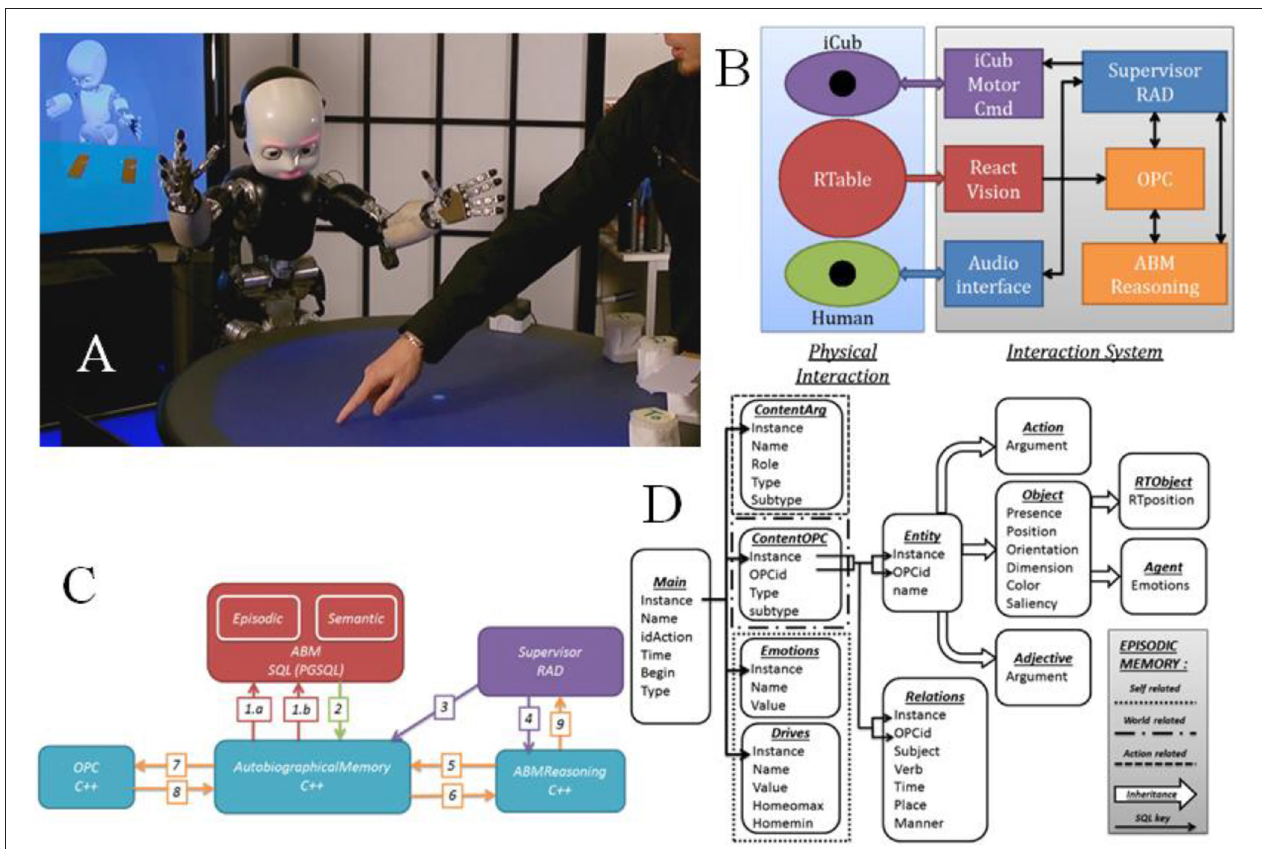
FIGURE 2 | (A) iCub robot interacting with the human. Mental model displayed on screen in upper left. (B) System architecture overview. Human and iCub interact face-to-face across the ReacTable, which communicates object locations via ReactVision to the object property collector (OPC). The Supervisor coordinates spoken language and physical interaction with the iCub via spoken language technology in the Audio interface. The autobiographical memory system encodes world states and their transitions due to human and robot action as encoded in the OPC. (C) Overview of the memory functioning including the ABM SQL Database, the Supervisor, the Reasoning module, and the OPC. This provides a partial zoom in on (B) . (D) Architecture of the episodic memory storage in PostgreSQL. The main data type is specified as ContentArg, ContentOPC. Each interaction has the content of the OPC at a given time (state of the world), but also, information concerning the context